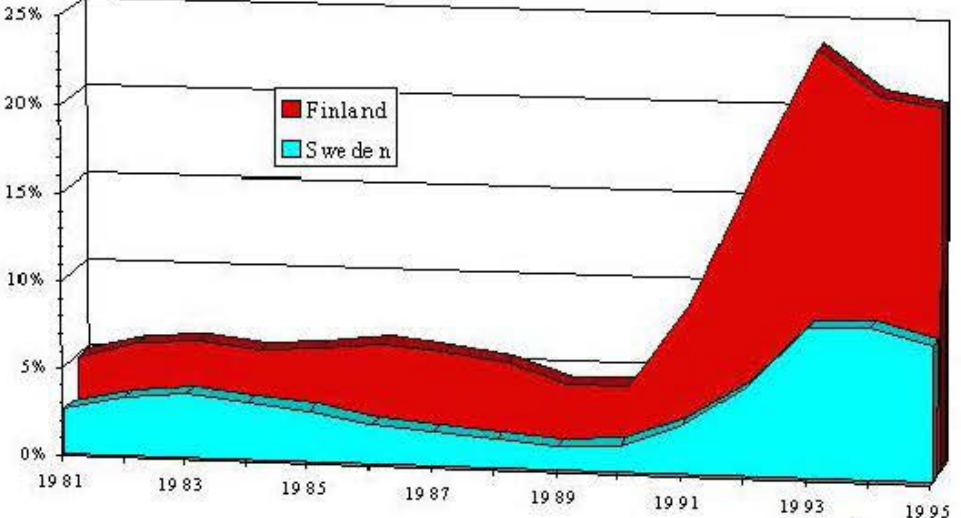
Figure 2. Finlamrs and Sweden's u1}!mplo7mci1t rates. 1981-98